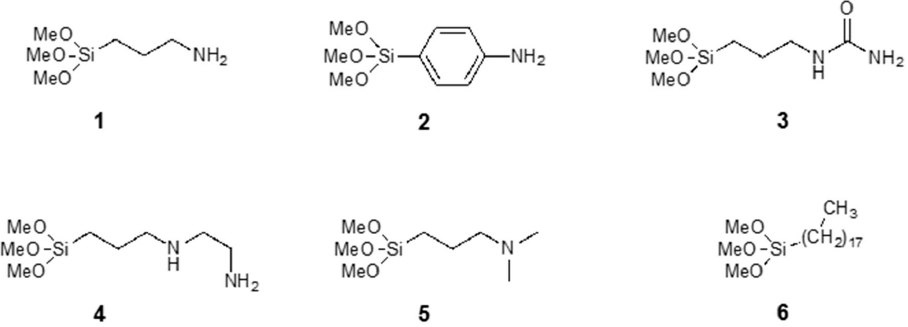
Figure 2. Chemical structures of the silanes used in this work.